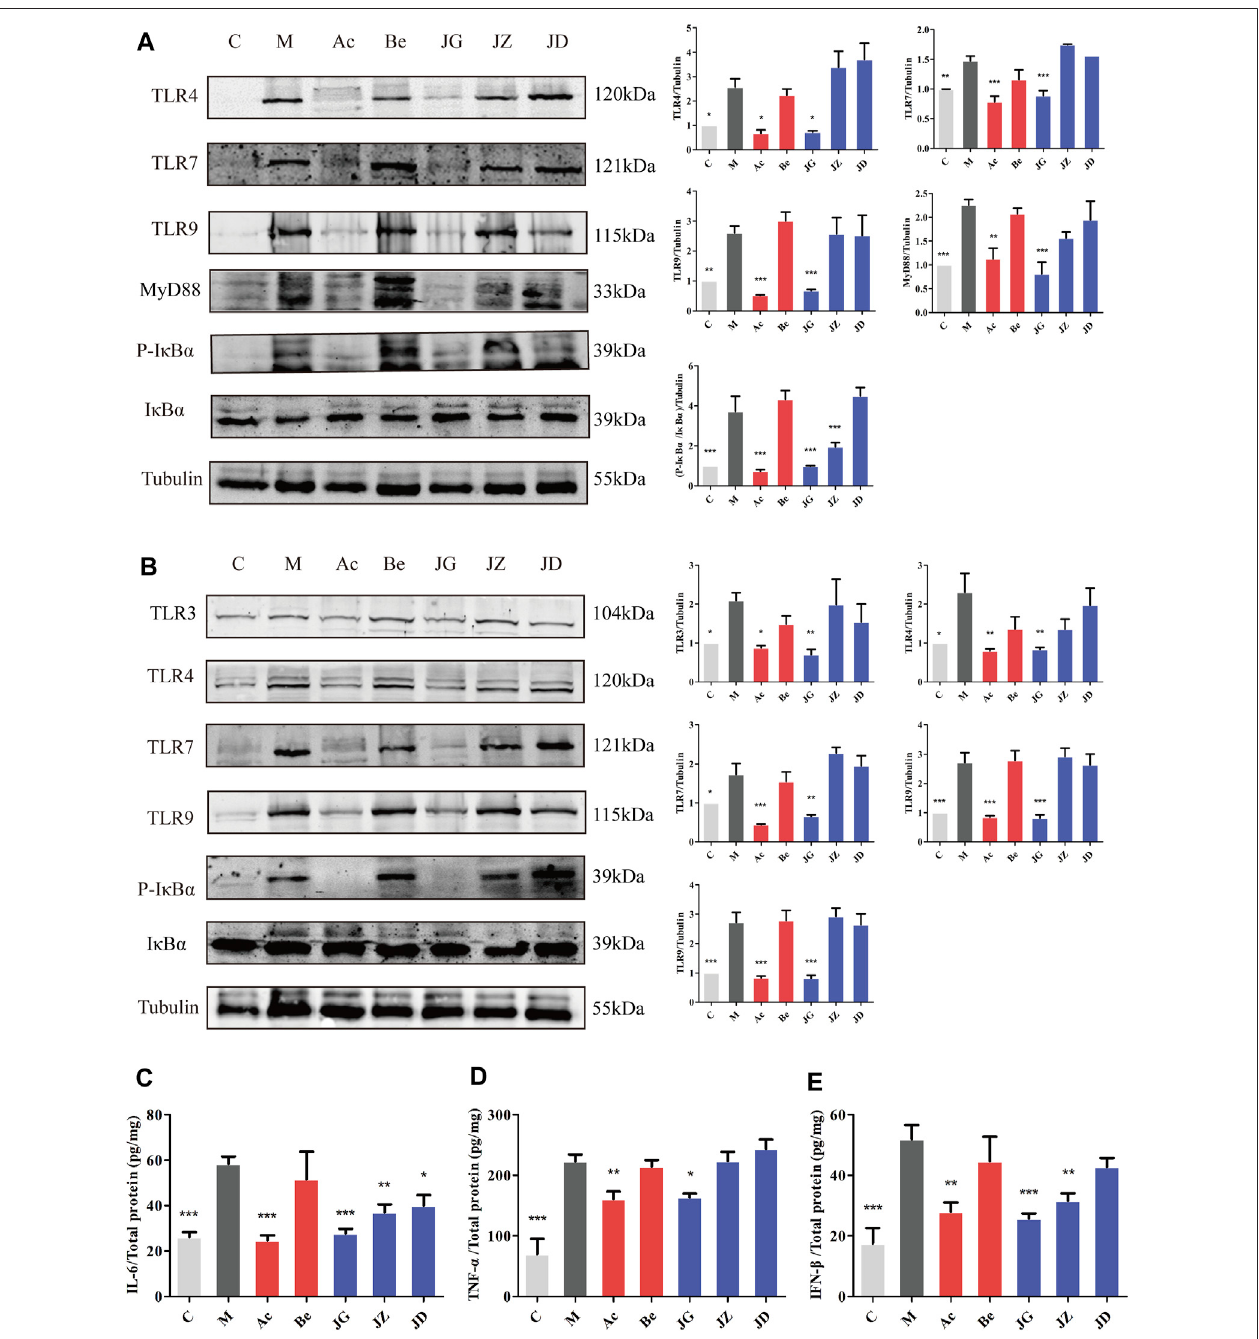
FIGURE 9 | Effect of JZ-1 on the TLR signaling pathway in vaginal (A) and vulvar (B) tissues of GH mice. On day 9 after modeling, the key proteins of the TLR signaling pathway, including TLR3, TLR4, TLR7, TLR9, MyD88, P-I κ B α , and I κ B α were measured by western blot. The in fl ammatory cytokine contents in vaginal tissue, including IL-6 (C) , TNF- α (D) , and IFN- β (E) , were determined by ELISA. JZ-1 downregulated the activation of the TLR signaling pathway and the expression of in fl ammatorycytokines.C,controlgroup;M,modelgroup;Ac,acyclovirgroup;Be,berberinegroup;JG,JZ,JD:2.5,1.5,and0.5 g/mlJZ-1group. *p ＜ 0.05, **p ＜ 0.01, ***p ＜ 0.001 vs. M